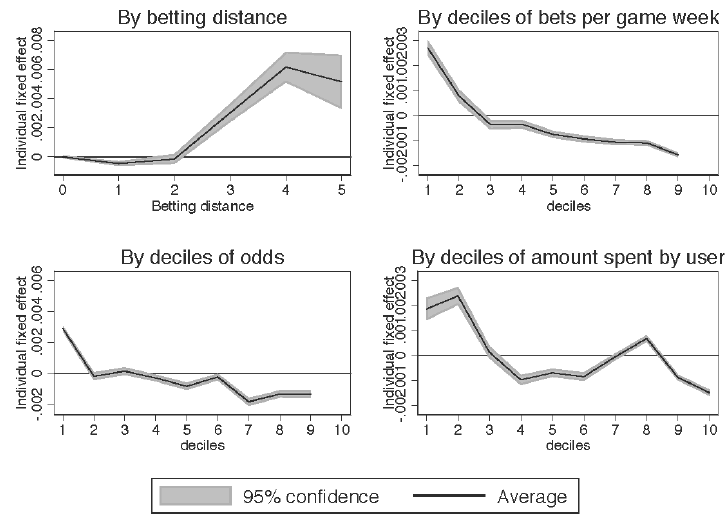
Figure A1. Individual fixed effects by various dimensions.